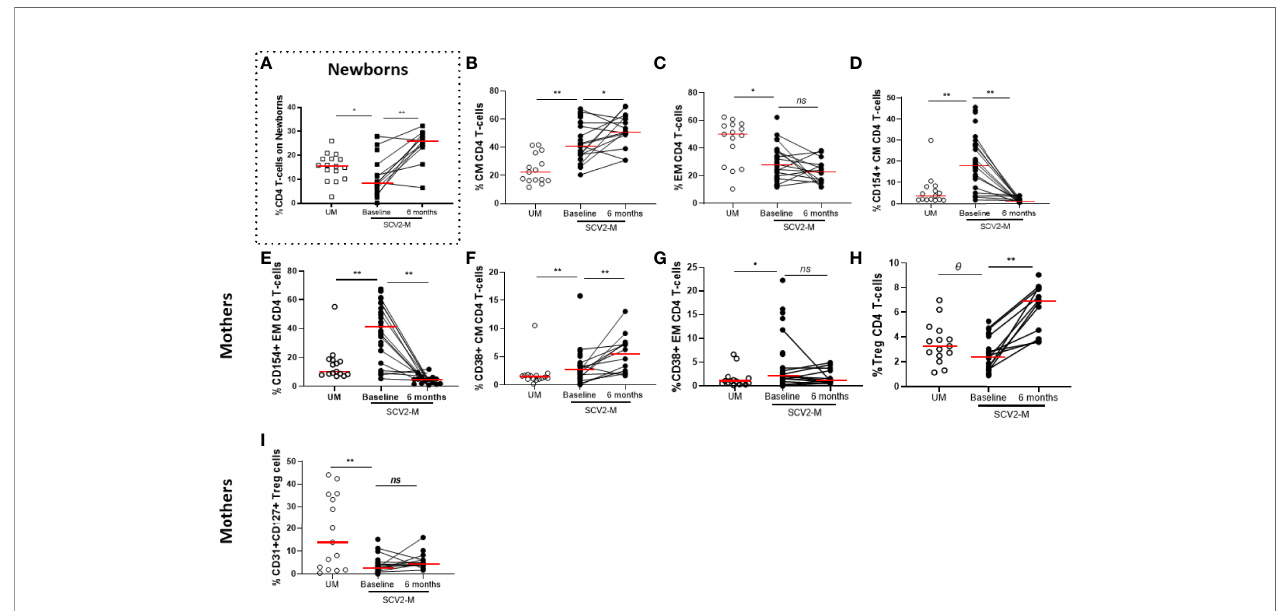
FIGURE 3 | Maturation pro fi le and activation markers on CD4 T lymphocytes and frequency of Treg cells. Frequency of total CD4 T lymphocytes in newborns (A) . Differences in Central and Effector Memory (CM and EM, respectively) subsets distribution in CD4 T cells (B, C) ; activation markers in CM and EM CD4 T-cell memory subsets (D – G) ; Treg cells proportion (H) and CD31, CD127 co-expression in Treg cells (I) . Mann-Whitney U-test was used to compare groups. Wilcoxon test was conducted to compare paired events. SCV2-M, SARS-CoV2 mothers ’ group; UM, Uninfected mothers ’ group. **p ≤ 0.01 , *p<0.05 , Ɵ 0.05 ≤ p ≤ 0.1 , ns p>0.1